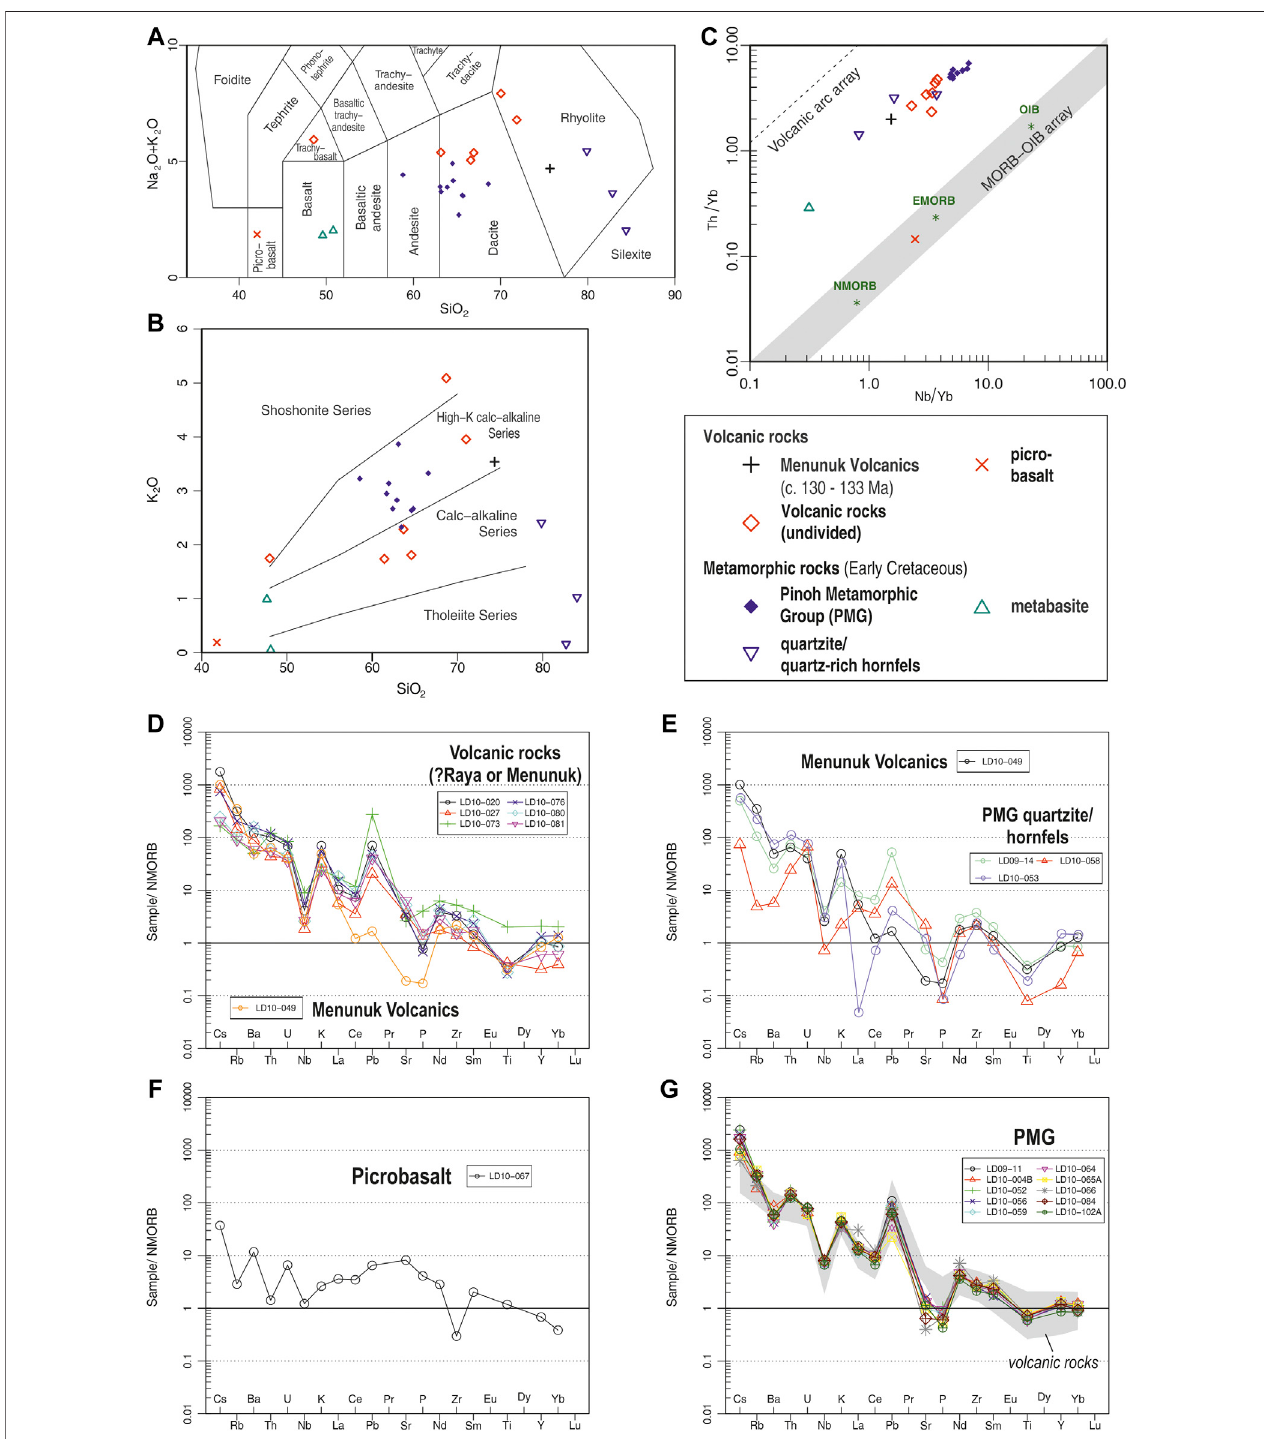
FIGURE 12 | Geochemistry classi fi cation diagrams and trace element spider diagrams of volcanic and metamorphic rocks of the Schwaner Mountains. (A) TAS diagram for classi fi cation of extrusive rocks (after Le Bas et al., 1986). (B) K 2 O-SiO 2 classi fi cation (after Peccerillo and Taylor, 1976). (C) Th/Yb-Nb/Yb classi fi cation diagram for extrusive rocks (after Pearce, 2008). (D – G) Trace element spider diagrams of volcanic and metamorphic rocks of the Schwaner Mountains normalised to NMORB(SunandMcDonough,1989)for: (D) Volcanicrocksamples, (E) MenunukVolcanicsampleandPMGquartzitesandhornfels, (F) Picrobasaltsample,and (G) PMG